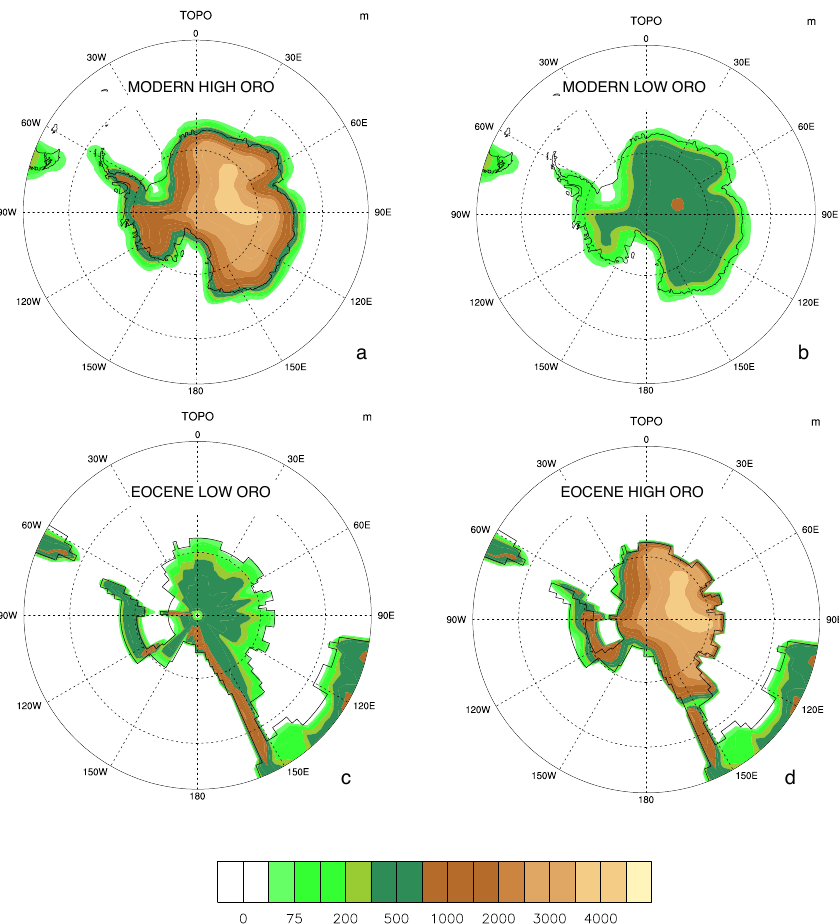
Fig. 2. (a) Antarctic topography in the modern glaciated high topography simulations (m). (b) Antarctic topography used in the unglaciated Figure 2. Antarctic topography (meters) used in the unglaciated Modern low topography simulations (a), modern low topography simulations. (c) Antarctic topography in the unglaciated Eocene simulation. (d) Antarctic topography in the Eocene Antarctic topography in the unglaciated Eocene simulation (b), Antarctic topography in the Modern glaciated simulation based on the modern-day Antarctic height. Oro sensitivity experiments in the text refer to changing these glaciated high topography simulations (c), Antarctic topography in the Eocene glaciated simulation based off of the Modern day Antarctic height (d).